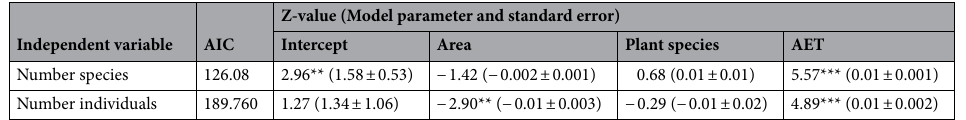
Table 2. Summary of negative binomial GLM (generalized linear model) model to the number of individuals and the number of species from 11 study sites at HNP. Tree dbh is the sum of dbh of trees in 20 × 20 quadrat.